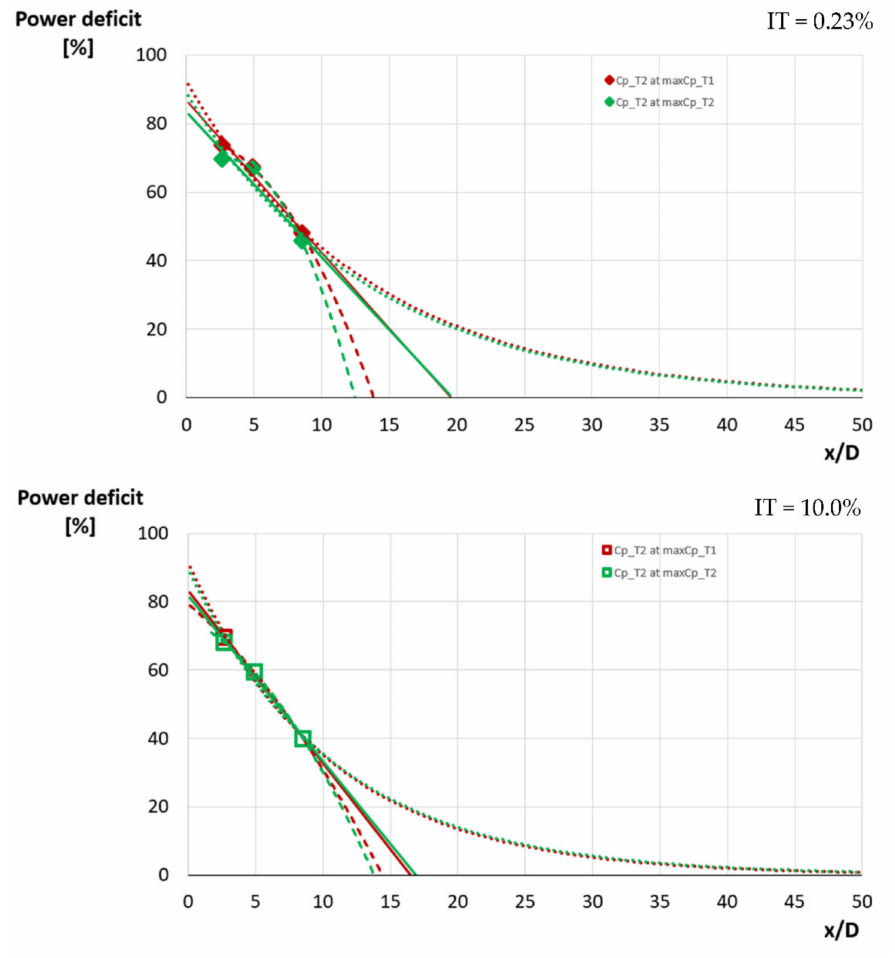
Figure 14. Power deficit and its recovery downstream T1 ( λ _T1 = 6): data points and their proposed modeling curves. IT = 0.23% ( top ) and 10.0% ( bottom